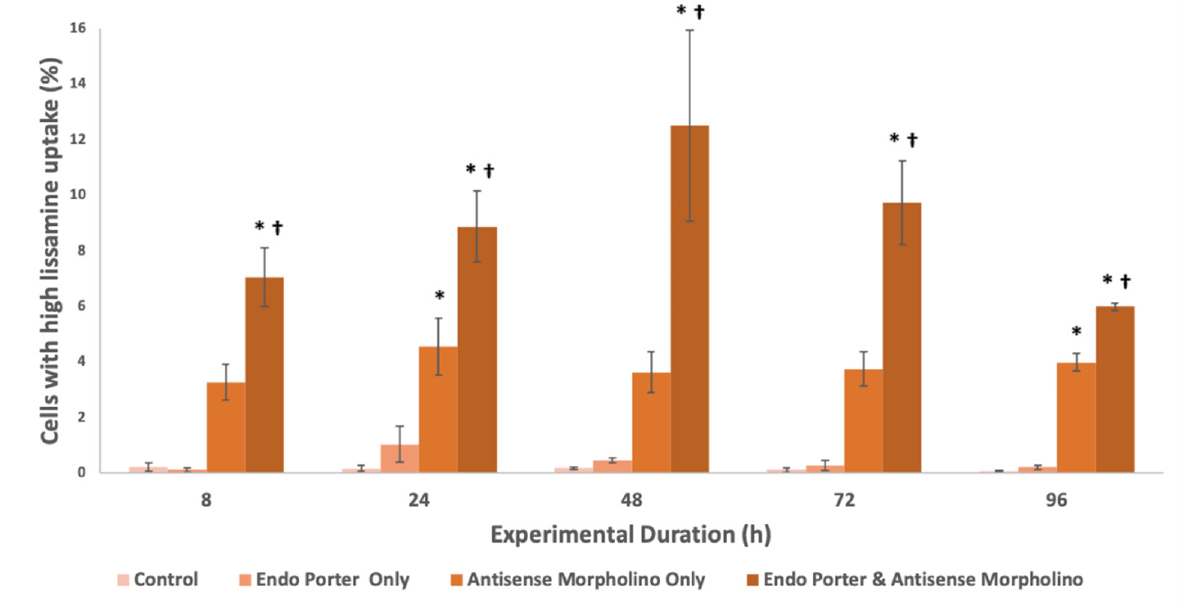
Figure 2. Percent of A.carterae populations with high Lissamine uptake after 48 h (cutoff 104 RFUs). Conditions included the control, Endo Porter only, antisense morpholino only, and the Endo Porter and antisense morpholino combined (N = 3). Statistical analysis was done using t -tests with pooled standard deviations. * Significantly different from ‘Control’ based on a p -value of < 0.05. † Significant difference between “Antisense Morpholino Only” and “Endo Porter & Anti-sense Morpholino” based on a p -value of < 0.05.